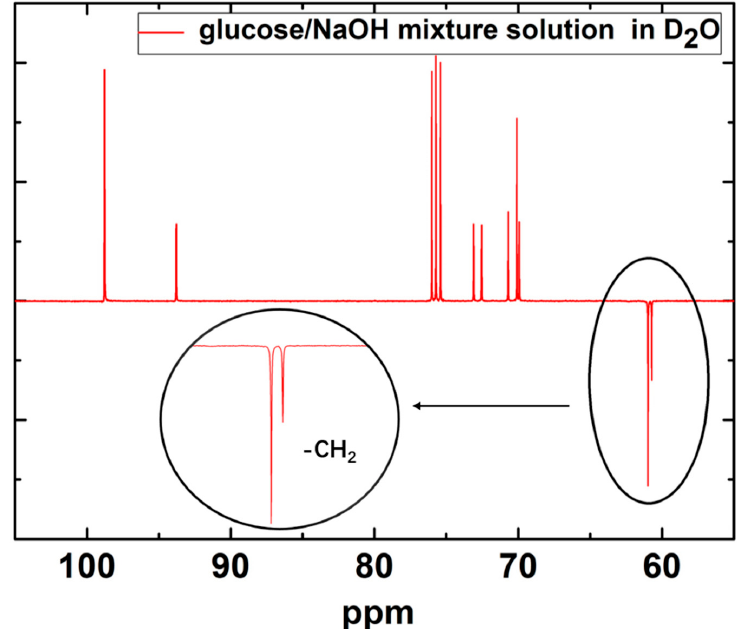
Figure 5. 13 C DEPTQ-135 NMR spectrum of glucose/NaOH mixture dissolved in D 2 O with a frequency of 125.78 MHz.